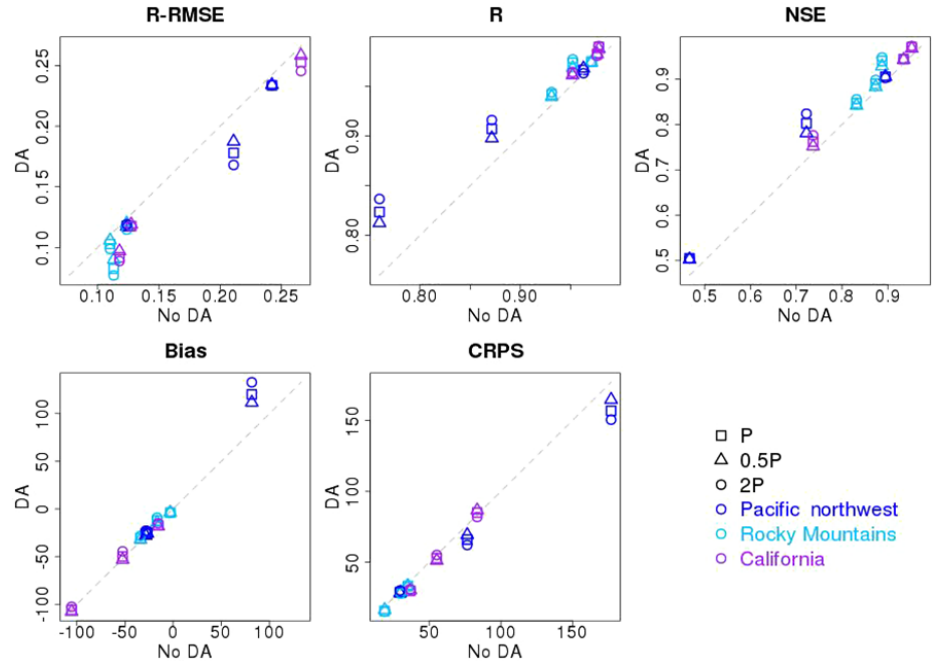
Figure 3. Evaluation metrics for April–July ensemble mean streamflow from the percentile-based interpolation method for the nine case basins using perfect forcing. The verification metrics from upper left to lower right are as follows: R-RMSE is the relative (normalized) root mean squared error, R is the linear (Pearson) correlation coefficient, NSE is the Nash–Sutcliffe efficiency, bias is the same as mean error, and CRPS is the continuous ranked probability skill